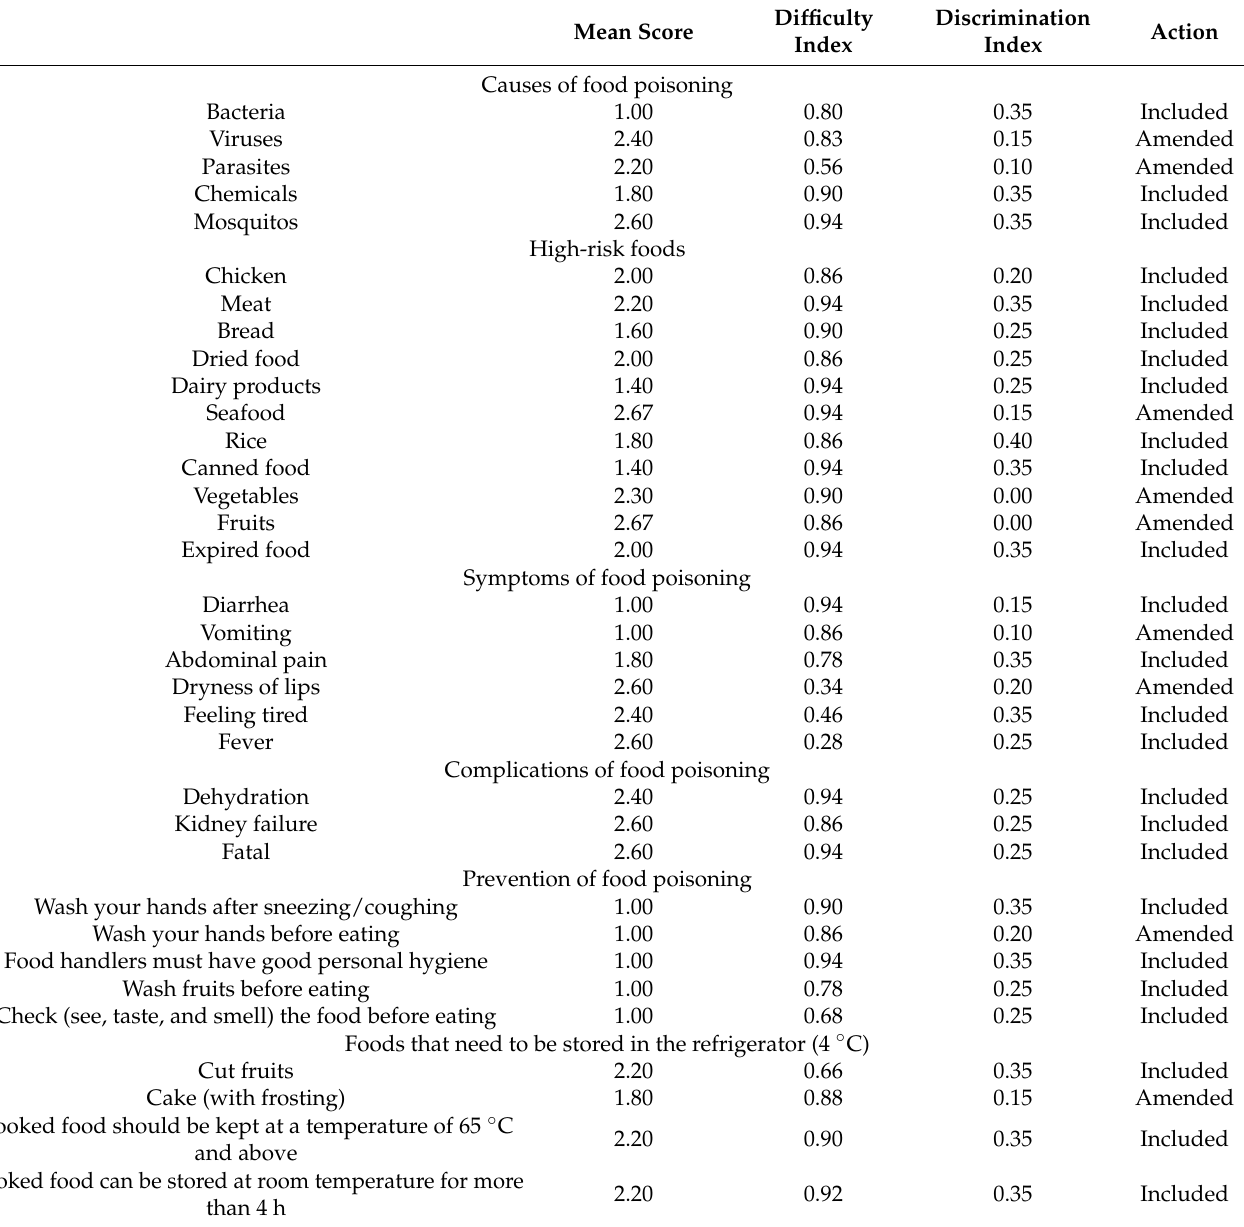
Table 2. The difficulty index and discrimination index for each item of the knowledge construct of food poisoning (N =